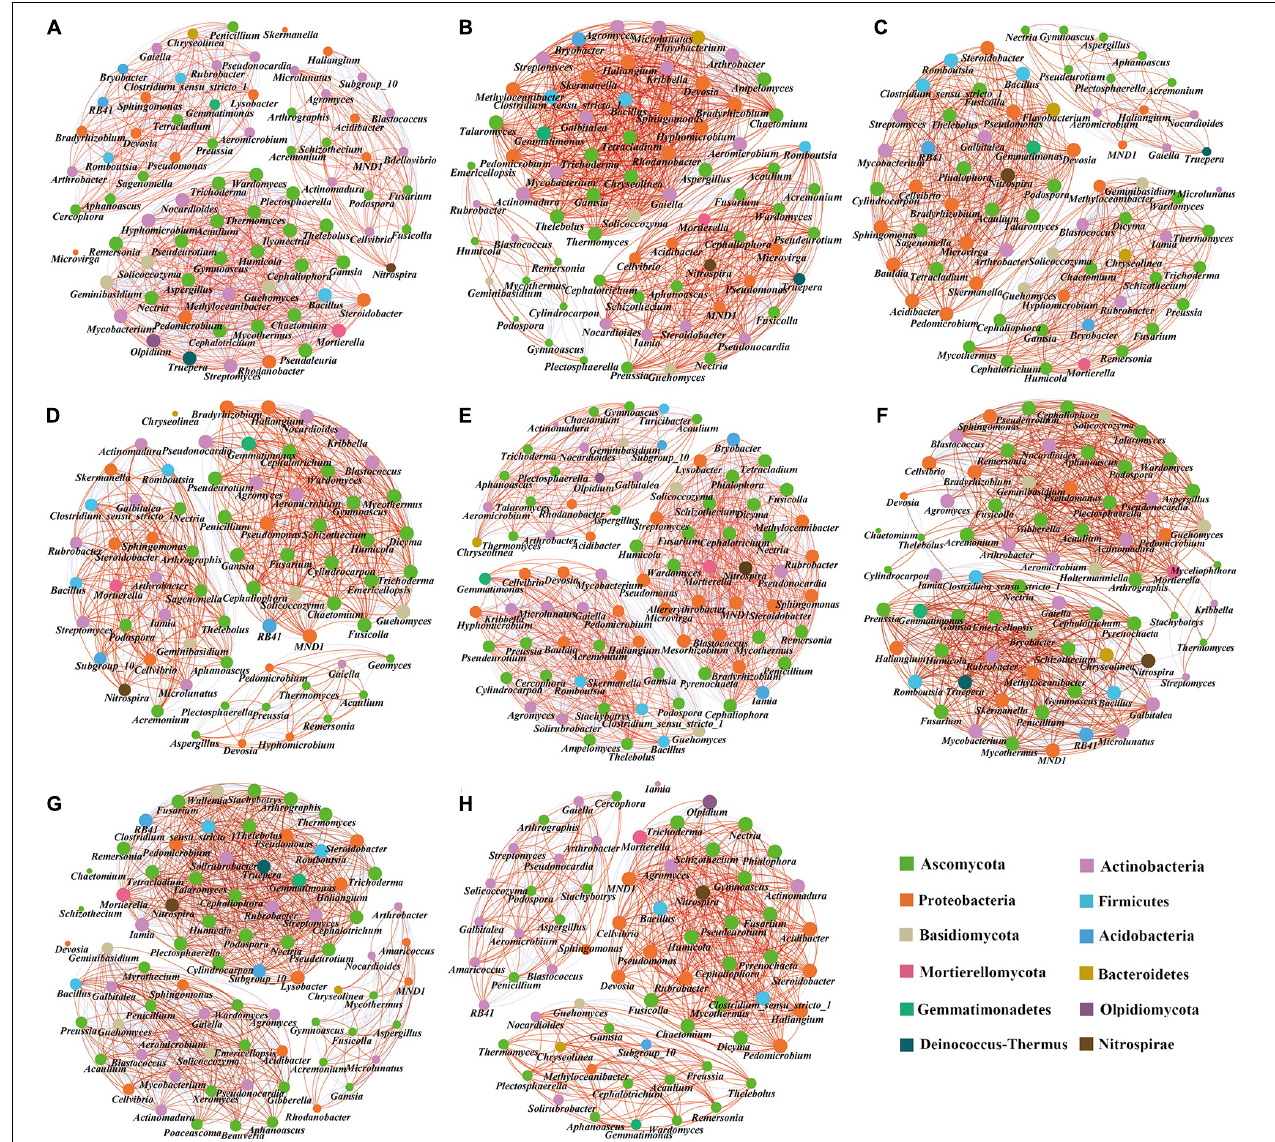
FIGURE 8 | Co-occurrence network analysis of soil microbial communities in different treatments. (A) T, (B) 0.3%T, (C) 0.6%T, (D) 1.2%T, (E) TO, (F) 0.3%TO, (G) 0.6%TO, and (H) 1.2%TO. A link represents a significant correlation (Spearman, | ρ | > 0.8, P < 0.05). The red line indicates a positive correlation, and the blue line indicates a negative correlation. The node size is proportional to the number of connections. Only bacteria with genus level abundance > 0.3% and fungi with genus level abundance > 0.1% are shown. T and TO indicate tomato monoculture and intercropped with potato–onion, respectively. 0, 0.3, 0.6, and 1.2% indicate the biochar